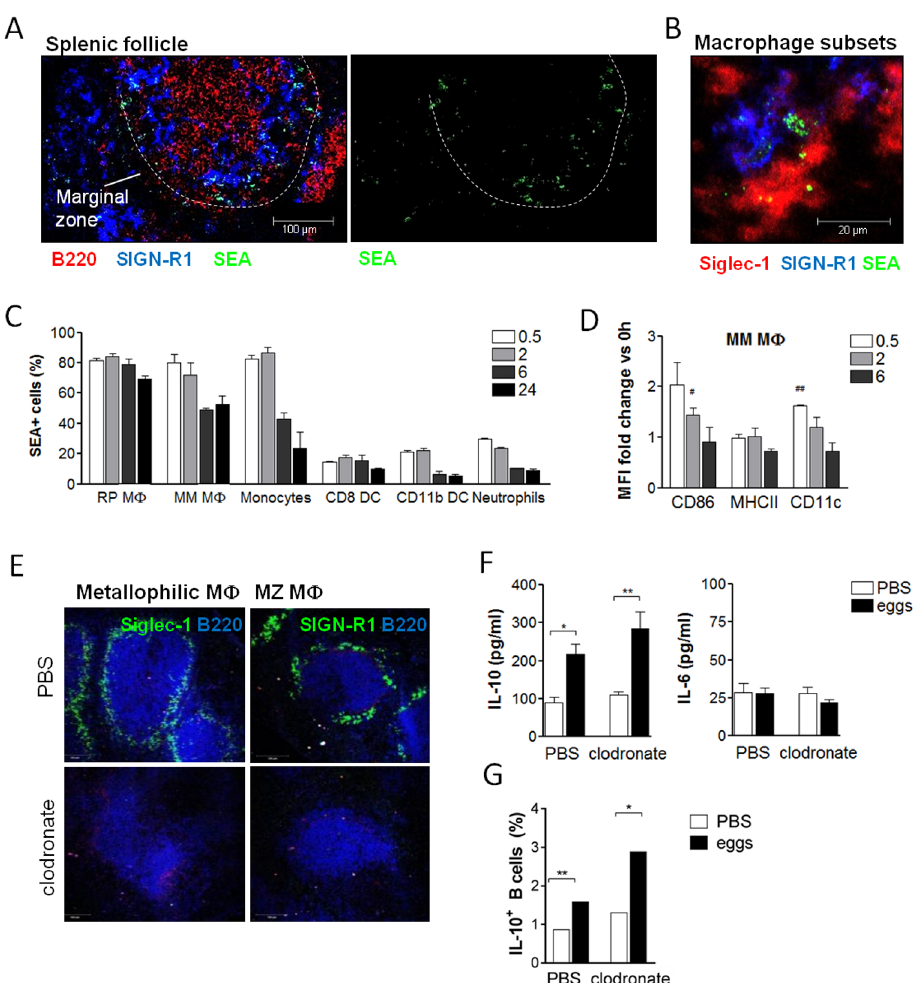
Fig 3. Macrophage subsets of the MZ bind SEA but are dispensable for schistosome antigen- mediated Breg cell induction. (A, B) Spleenswere snap-frozen 30 minutes after i.v. injectionof 200 μ g fluorescently labeled SEA, and bindingof SEA analyzedby fluorescence microscopy. Images are representative for 2 experiments with N = 5 mice and 3 folliclesper section imaged. (A) SEA clusteredaround the marginal zone of the spleen (indicatedby white dashedline). (B) SEA localizedin the marginalzone to macrophages expressingSiglec-1(marginalmetallophilic macrophages) and SIGN-R1 (MZ). (C, D) Mice were i.v. injectedwith fluorescently labeledSEA and splenocytesharvested30 minutes-24 hours later. (C) Frequency of SEA-positive cells in varioussplenocytesubsets as determined by flow cytometry (gating schemes see S4 Fig). M Φ , macrophages; RP, red pulp; MM, marginalmetallophilic; DC, dendriticcells. (D) Mean fluorescence intensity of surface markers on MM macrophages calculatedas fold increase versus the expressionat time-point 0 hours. Summary of 2 experiments with N = 2. (E-G) Mice were i.p. injected with 200 μ l clodronate-containingliposomesor PBS control liposomes. Three weeks later, mice were i.p. injected with two doses of 5000 eggs. Seven days after the last egg injection, splenicB cells were restimulated for 2 days with SEA. (E) Absenceof splenicSiglec-1and SIGN-R1-expressingmacrophage subsets at the time- point of spleen collectionwas confirmedby fluorescence microscopy. B cells were stainedwith B220. (F) Cytokineconcentration in culture supernatants as determinedby ELISA. (G) Intracellular IL-10 expressionof B cells after additionof BrefeldinA to the last 4 hours of the culture. One representative (N = 5) out of 2 similar experiments is shown. Significantdifference by Mann-Whitney test is indicatedwith * p < 0.05, ** p < 0.01. Significance as determined by one-sample t-test of log-transformed data is indicatedwith # p < 0.05, ## p < 0.01.